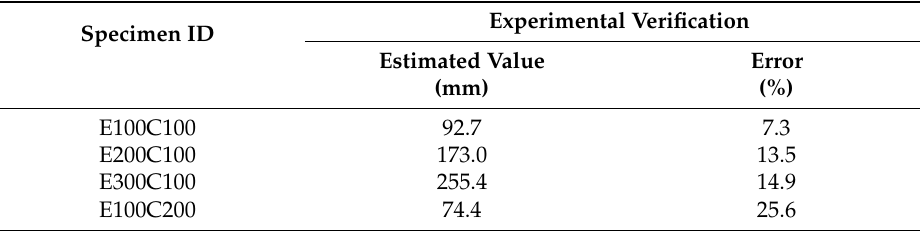
Table 4. Estimated embedment depth of the anchor bolt in experimental